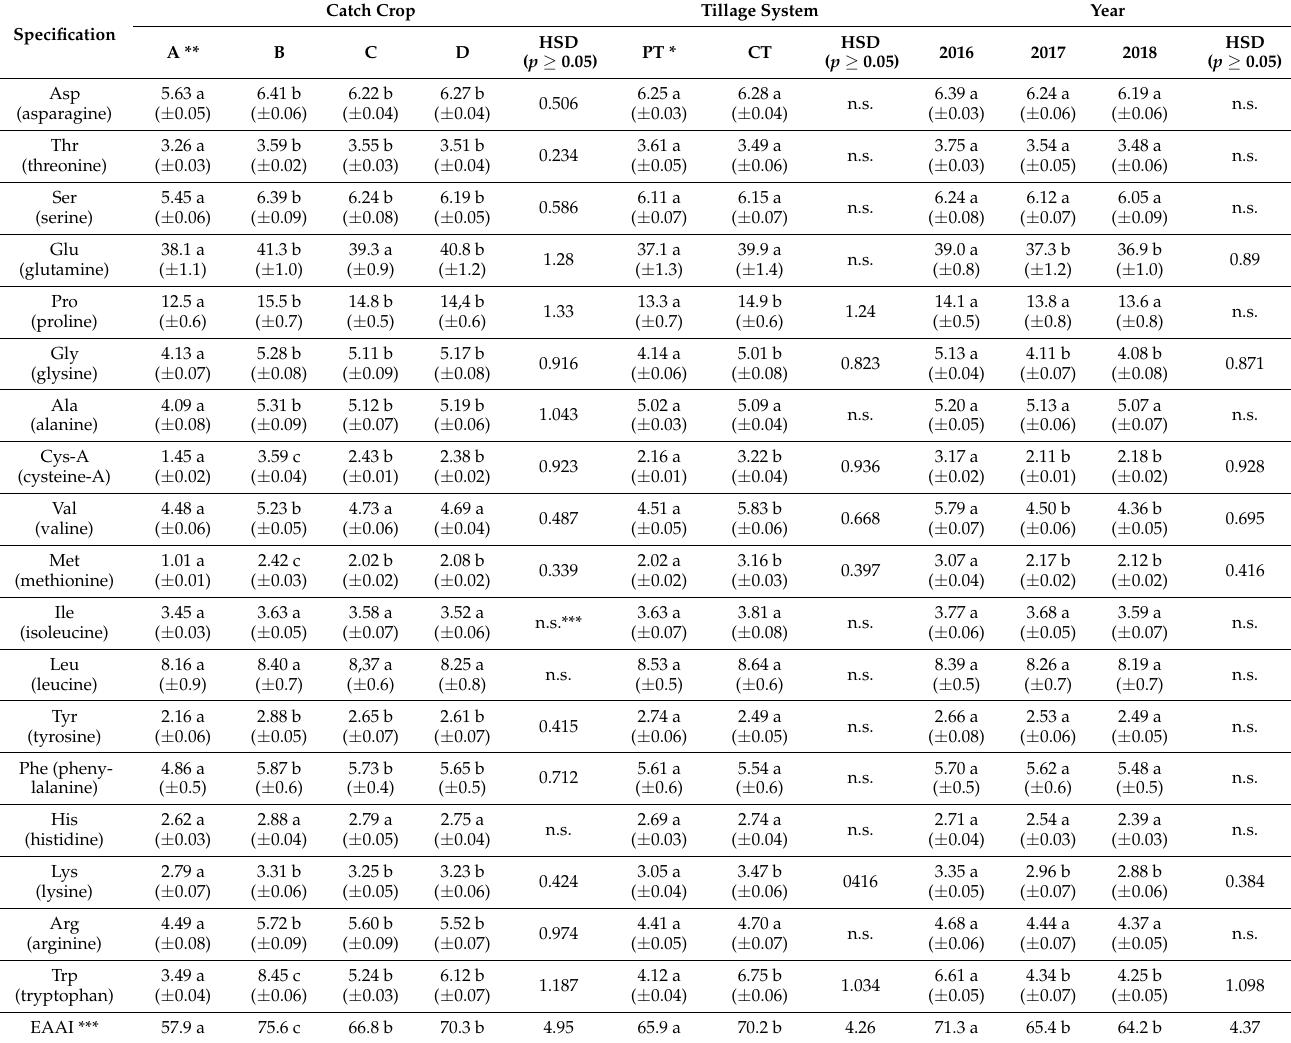
Table 9. Amino acid content in spring wheat grain (mg · g − 1